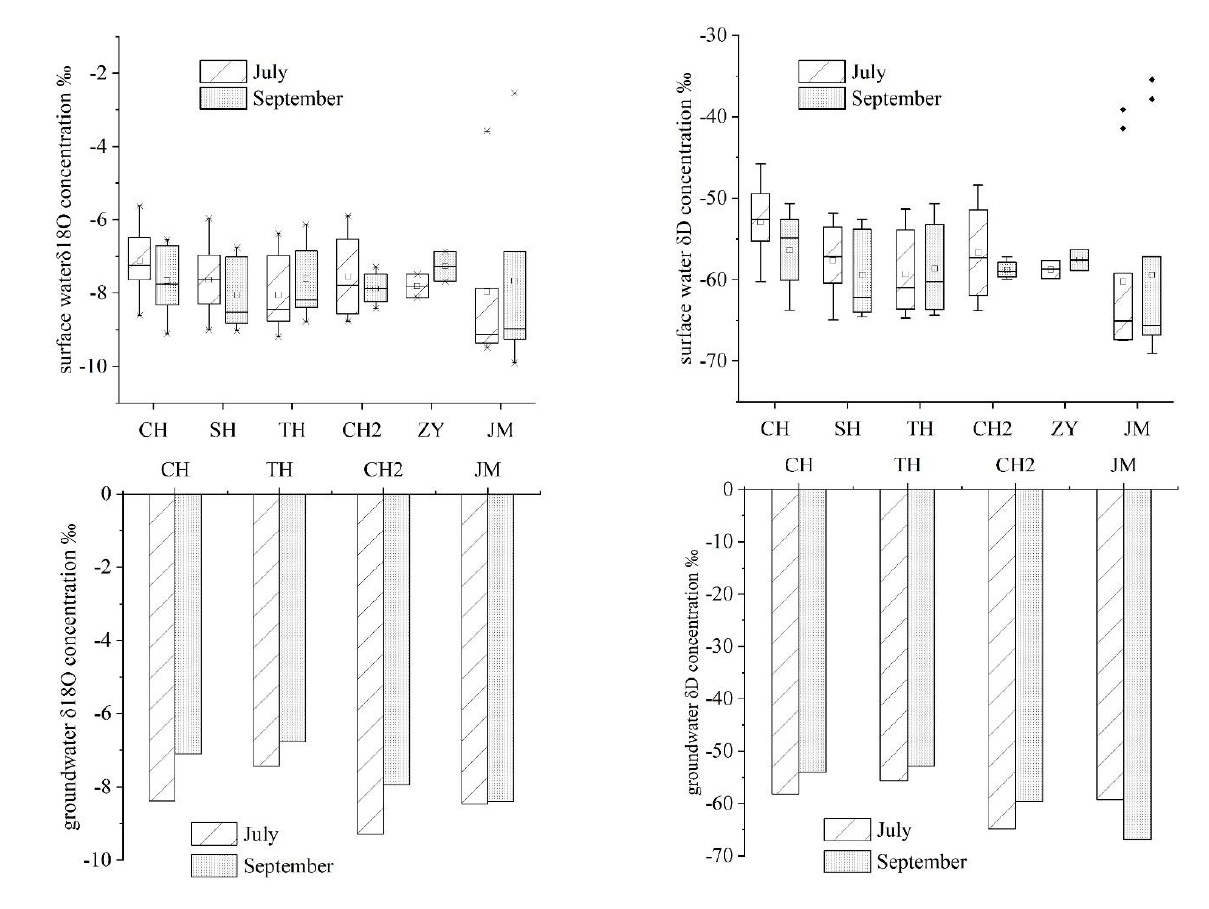
Figure 4. Distribution of δ D and δ 18 O in surface water and groundwater sampled twice in the mountainous watershed of Daqing River (CH—Ci river, SH—Sha river, TH—Tang river, CH2—Cao river, ZY—Zhongyi river, JM—Juma river).